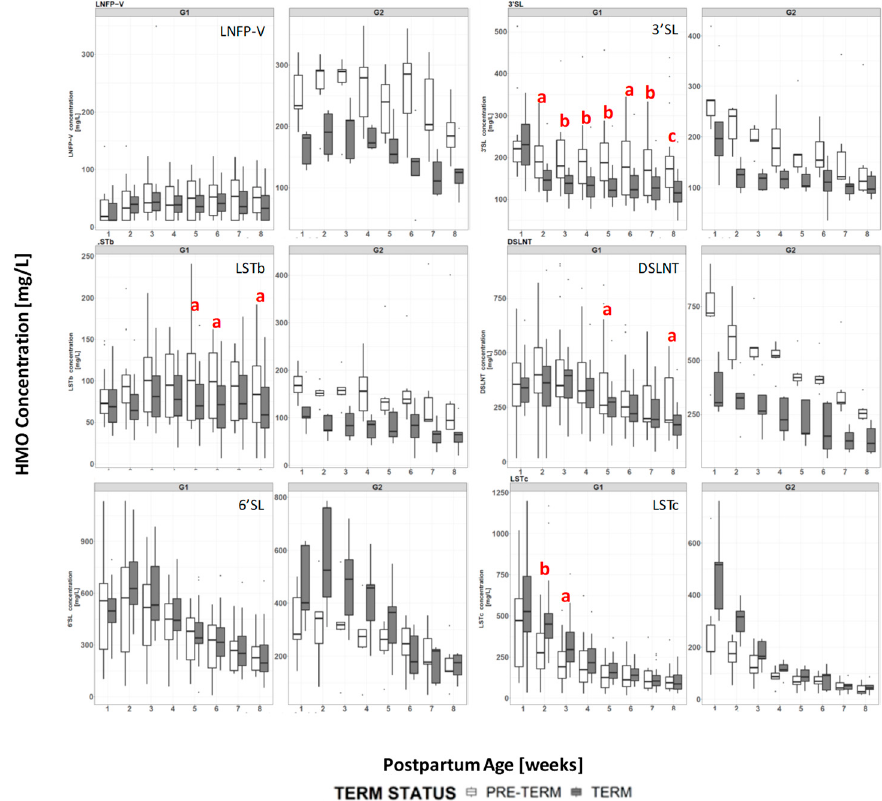
Figure 5. Comparison of selected HMO concentrations in group 1 (G1) and group 2 (G2) term (grey bars) and preterm (white bars) milk. a: p < 0.05, b: p < 0.005 c: p < 0.0005. Significance not tested in G2 milk due to low number of subjects (5 for each arm).